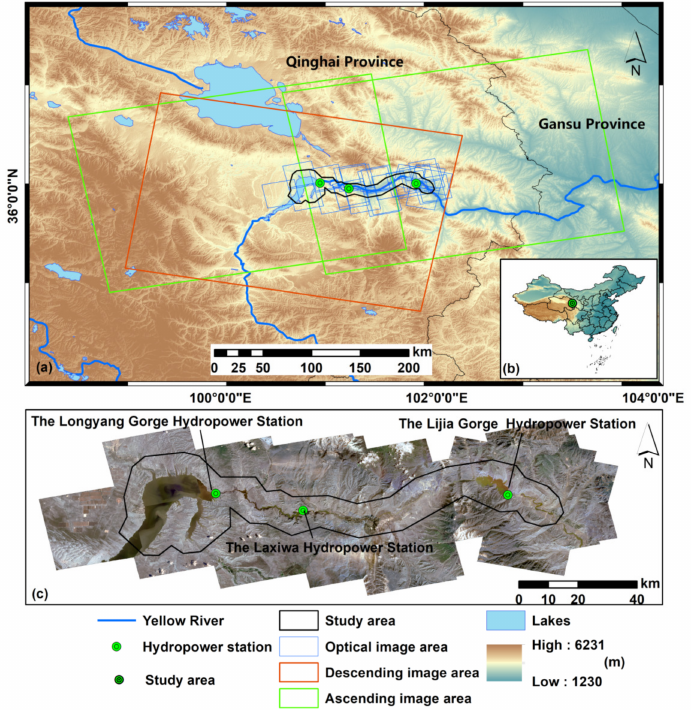
Figure 1. Nested study area maps. Red and green boxes in ( a ) denote the footprints of ascending and descending Sentinel-1 images, respectively. ( b ) shows the location of the study area. ( c ) show the optical images’ location.